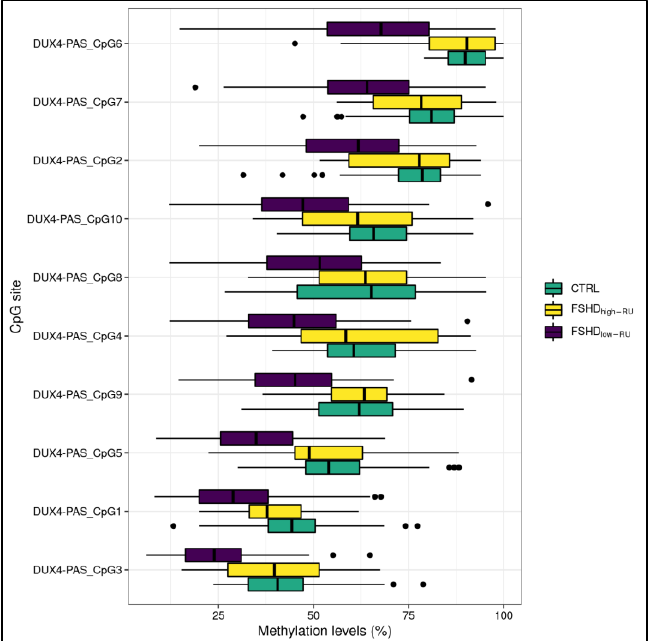
Figure 3. A boxplot showing the methylation levels related to DUX4 -PAS CpG sites of FSHD low-RU ( n = 121), FSHD high-RU ( n = 12) and CTRL subjects. The lower and upper hinges correspond to the 25th and 75th percentiles of the distribution. The whiskers extend from the hinge to the largest value no further than ±1.5 × IQR (where IQR is the inter-quartile range, namely distance between the first and third quartiles). Data points beyond the whiskers are plotted individually.